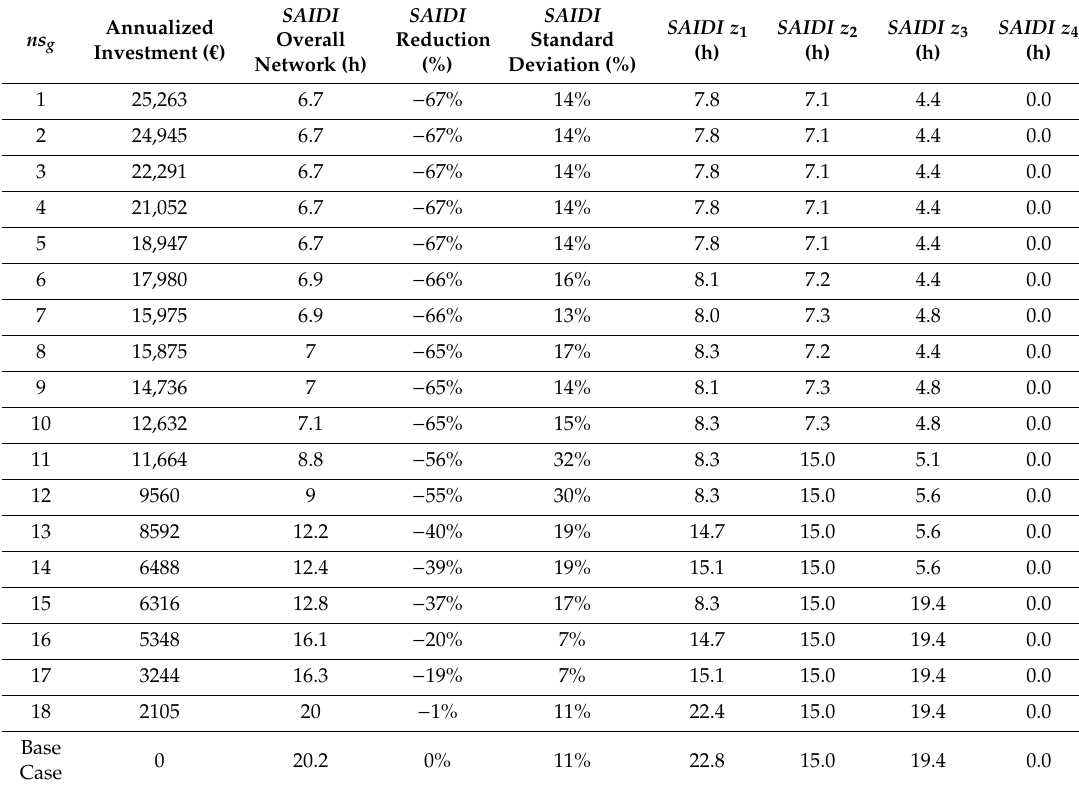
Table 5. Optimal network solutions for the case study